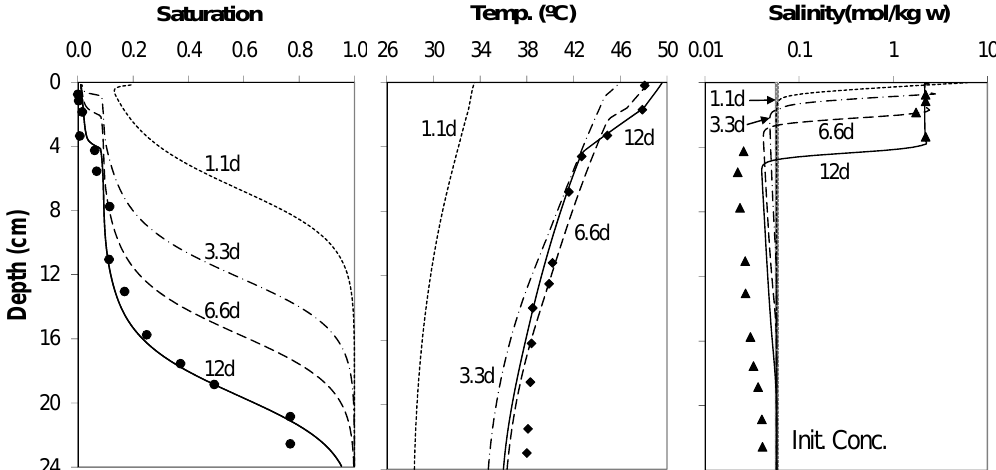
Fig. 3. Profiles of saturation, temperature and salinity measured at the end of the experiment (symbols) and computed (lines). The time evolution is shown for four different times (after 1.1 days, 3.3 days, 6.6 days and, at the end of the experiment, 12 days). Note that salinity is expressed as concentration in water to facilitate the analysis of mass transport